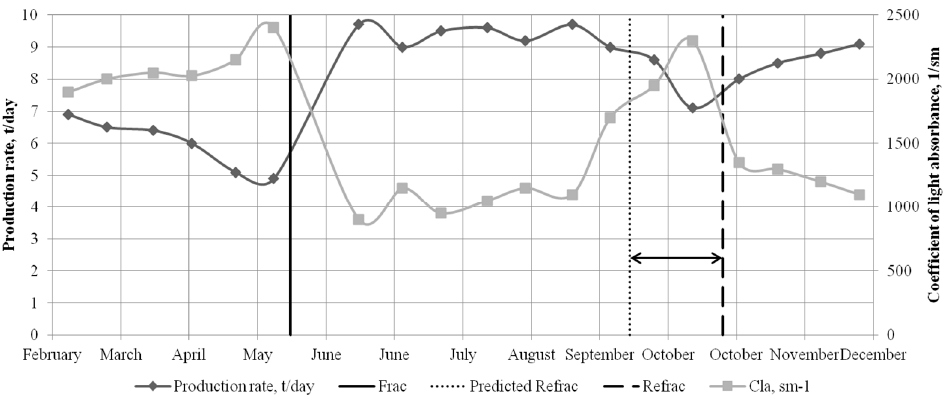
Figure 1. Variation coefficient of coefficient of light absorbance vs cumulative oil production [96].